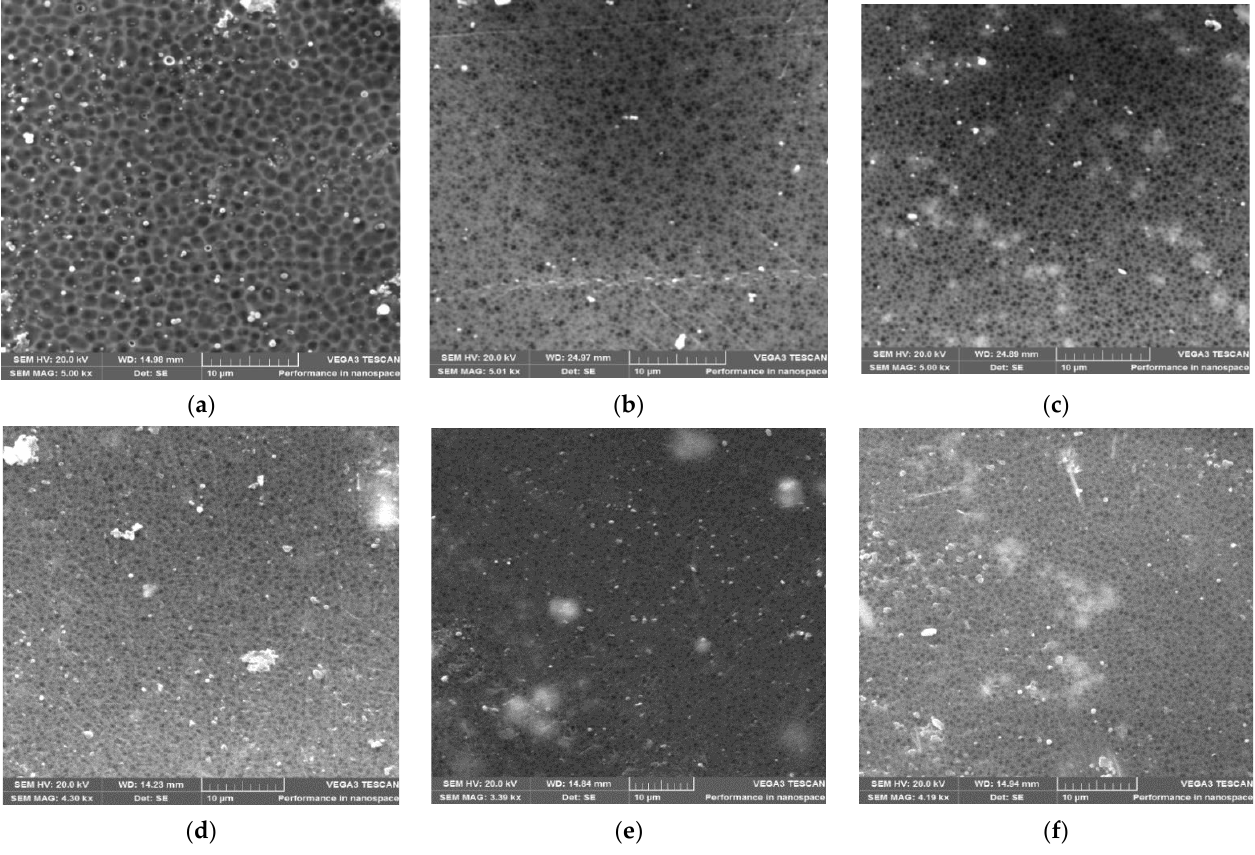
Figure 3. SEM surface micrographs of C60-ZSM-22/PES membrane materials prepared using C60- ZSM-22 as zeolite additives: ( a ) PES, ( b ) 0.1 wt.% C60-ZSM-22/PES, ( c ) 0.3 wt.% C60-ZSM-22/PES, ( d ) 0.5 wt.% C60-ZSM-22/PES, ( e ) 0.75 wt.% C60-ZSM-22/PES, and ( f ) 1.0 wt.% C60-ZSM-22/PES via